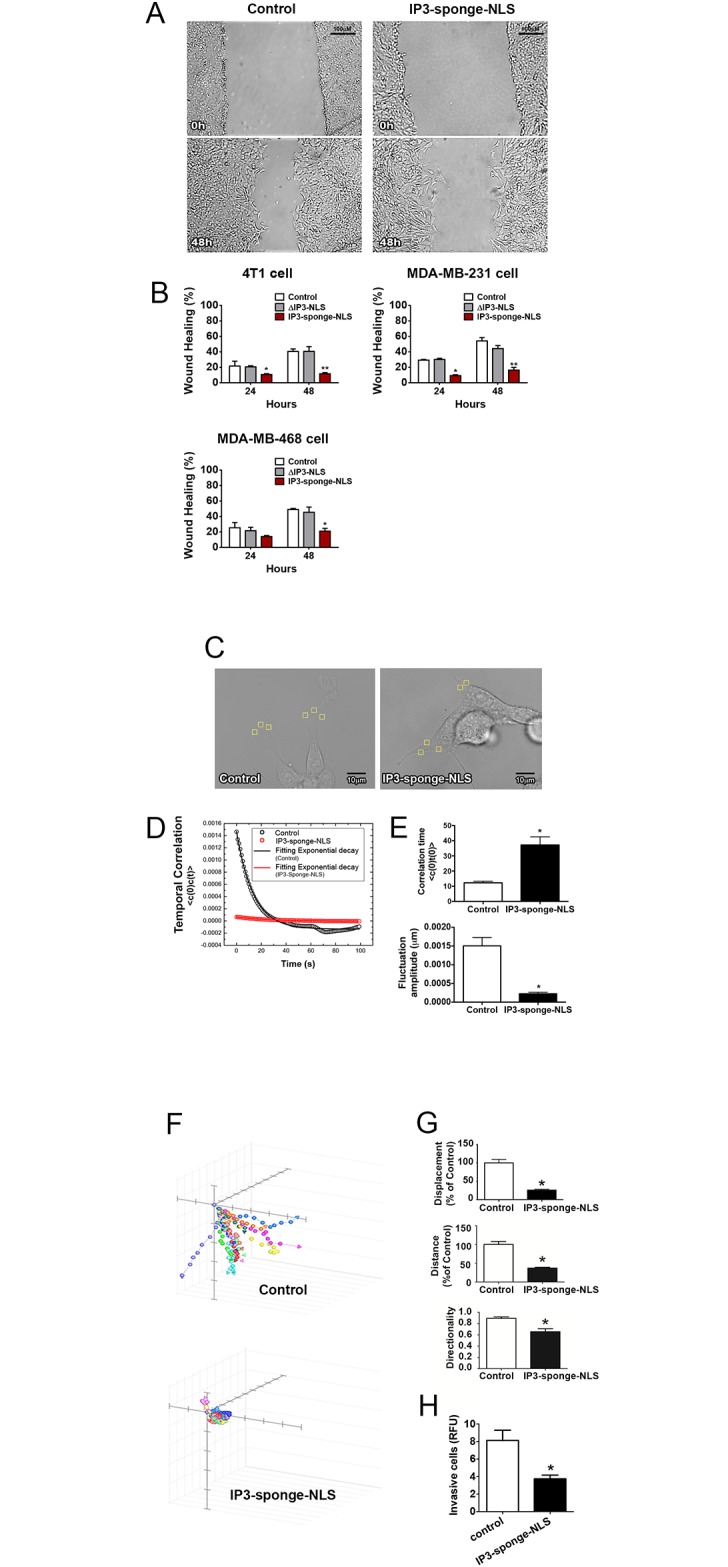
Nuclear IP3 buffering reduces breast cancer cells motility.(A) Representative image of in vitro wound healing assay performed with 4T1 cells. Images were selected from a representative well 48 hours after nuclear IP3 buffering. Scale bar = 100μM. (B) Average of wound healing closure 24 and 48 hours after nuclear IP3 buffering (n = 5 wells/group, for each time point). Results represent % of initial wound area (0 hours). (C) Bright field representative image of defocusing microscopy experiment performed with 4T1 cells. Yellow squares represent area of temporal correlation analyses. Scale bar = 10μm. (D) Correlation temporal function (<c(0)t(0)>) representative graph. (E) Average correlation time values. Results are average values of 3 areas per cell and 3 cells per group. Average fluctuation amplitude values. Results are average values of 10 areas per cell and 3 cells per group. (F) Tracking of individual 4T1 cells. Migratory cells, located at the limit of the wound, were selected and nuclear cell position was assessed in 20 minutes intervals during 4 hours (n = 20 cells/group). (G) Average displacement (upper panel), traveled distance (middle panel) and directionality (lower panel) in each group. Data are shown as % of control. (H) Average 4T1 cell invasion through Matrigel in both experimental groups; data showed by relative fluorescence units (RFU)(n = 3 individual experiments/group). * = p <0.05 versus control. Values are expressed as mean ± SD.